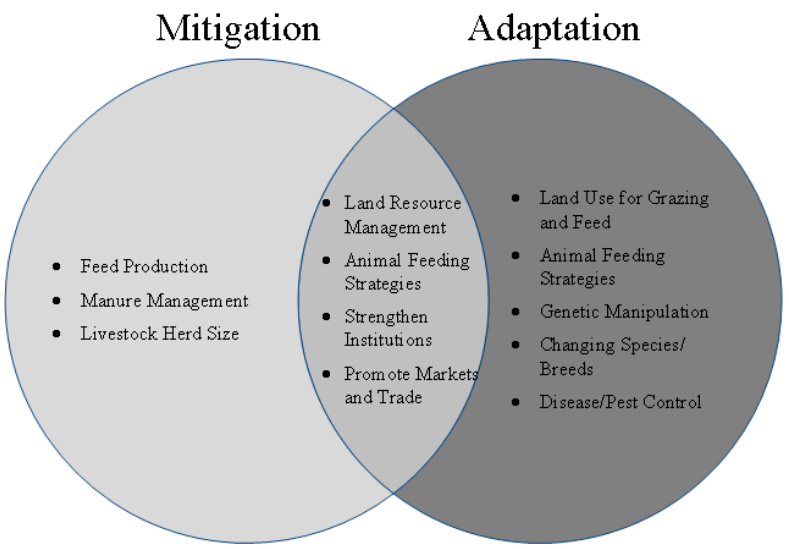
Figure 1. Venn Diagram of Strategies for Mitigation and Adaptation in Livestock Sector.